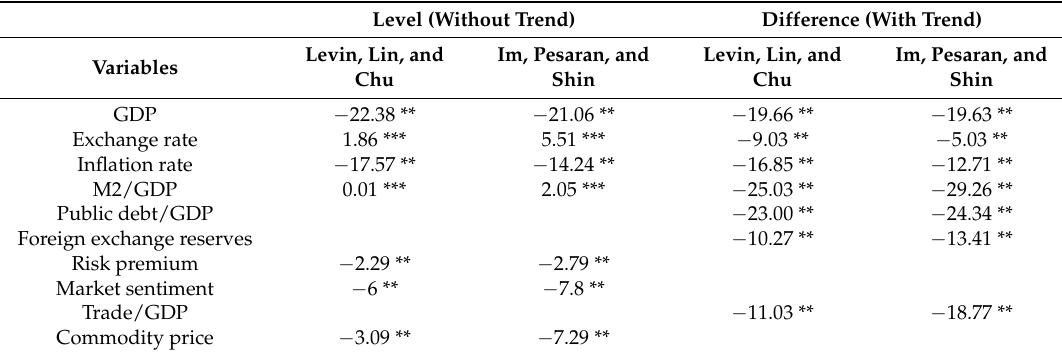
Table 2. Panel unit root test.